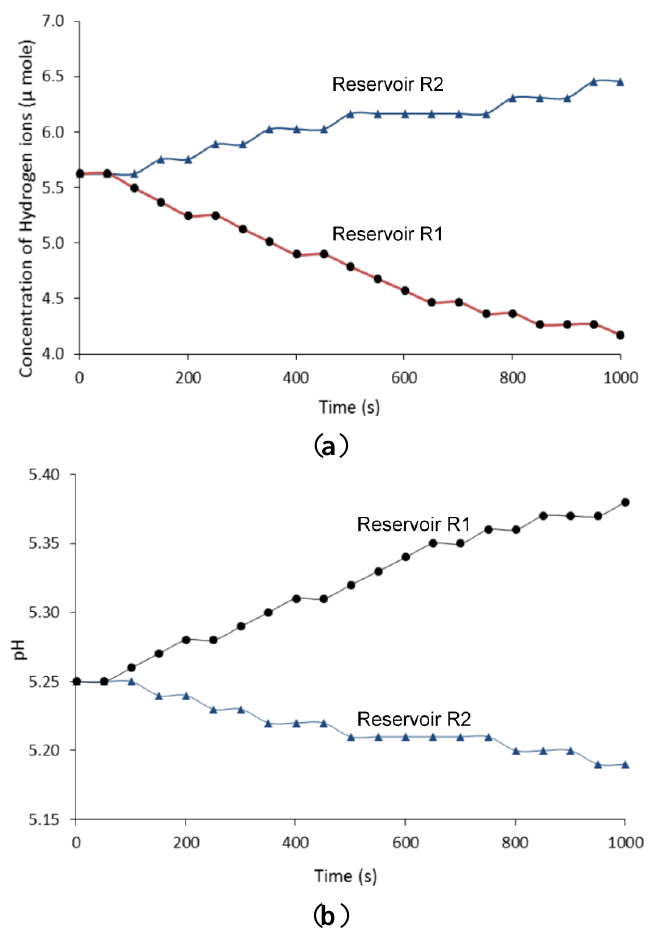
Figure 7. The change in H + ion concentration and pH over time of the two reservoirs separated by the bR-PAA transducer when exposed to a fixed 18 mW, 568 nm light source. ( a ) Change in H + ion concentration over time. ( b ) The observed pH in the adjacent solutions over